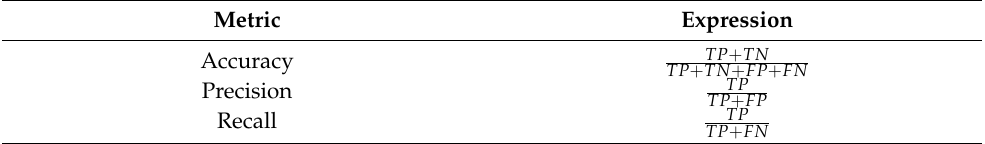
Table 5. Classification performance metrics.